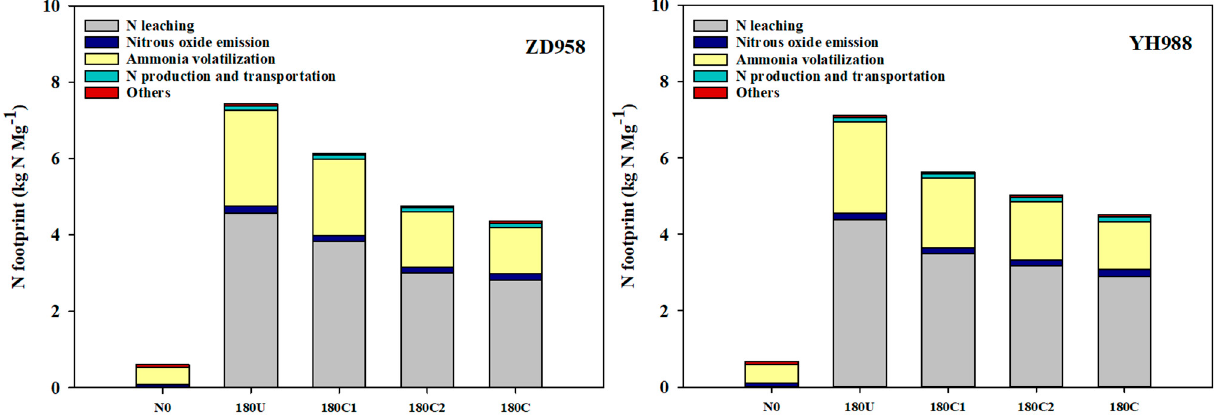
Figure 5. Average N footprint across the 2019 and 2020 growing periods in the summer maize system. N0, no N; 180, 180 kg N ha − 1 ; U, solely urea; C1, ratio of controlled-release nitrogen to urea nitrogen is 1:2; C2, ratio of controlled release nitrogen to urea nitrogen is 2:1; C, all CRU. Compared to the N180U treatment, N180C1, N180C2, and N180C reduced N leach-